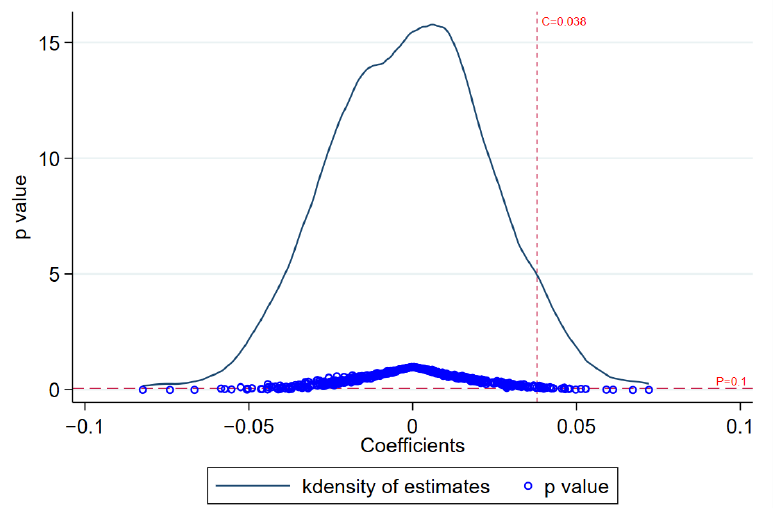
Figure 4. Placebo test